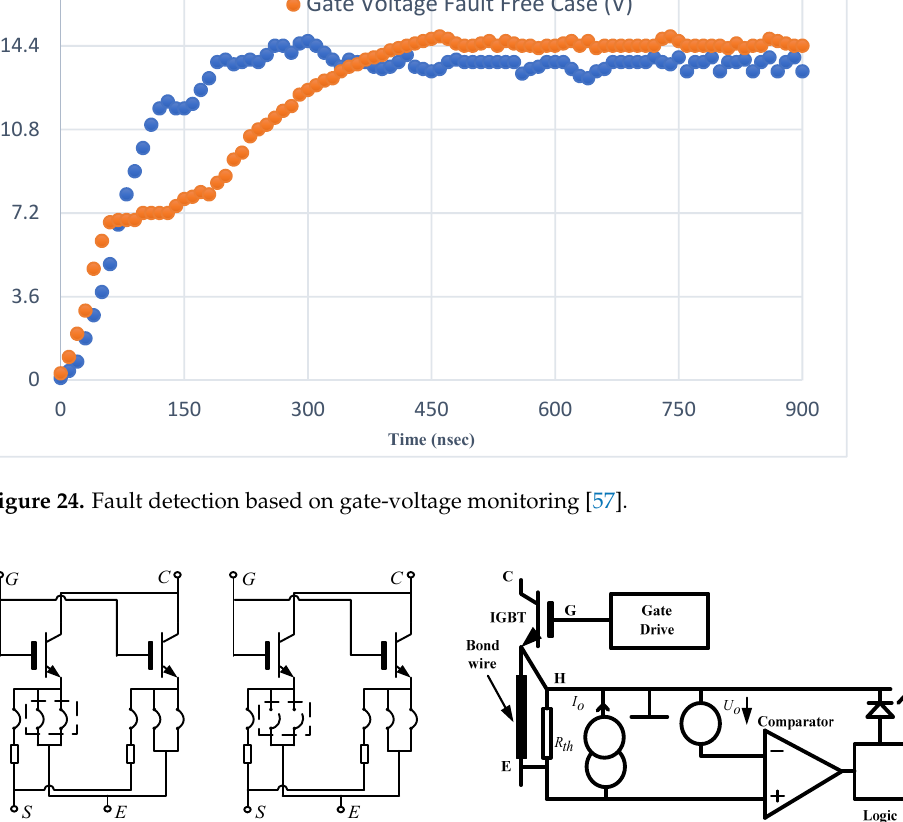
Figure 25. Emitter bond wire liftoff detection for IGBTs in parallel. ( a ) Equivalent circuits without (left) and with (right) emitter bond liftoff [58] and ( b ) Sensor based CM technology [59].